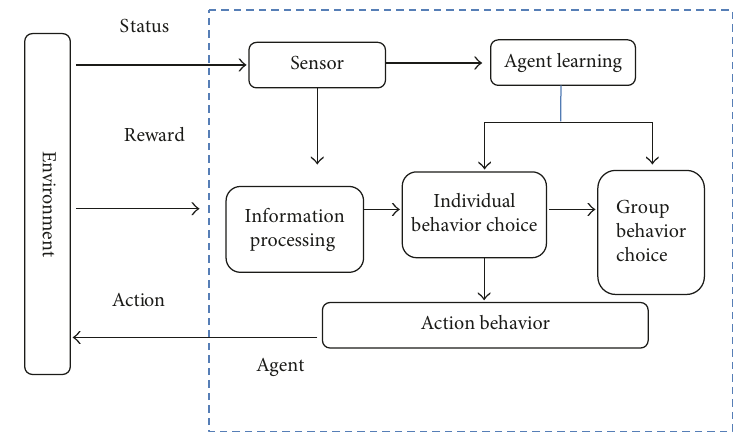
Figure 3: Basic principles of Agent’s reinforcement